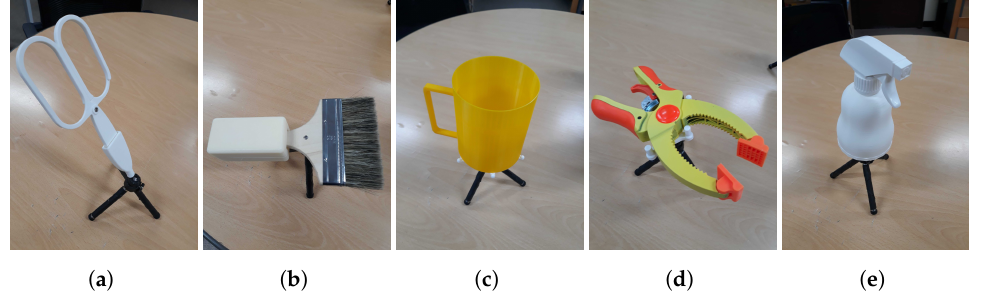
Figure 6. Five objects used for the experiment. ( a ) Scissors. ( b ) Brush. ( c ) Cup. ( d ) Clamp. ( e ) Spray bottle.